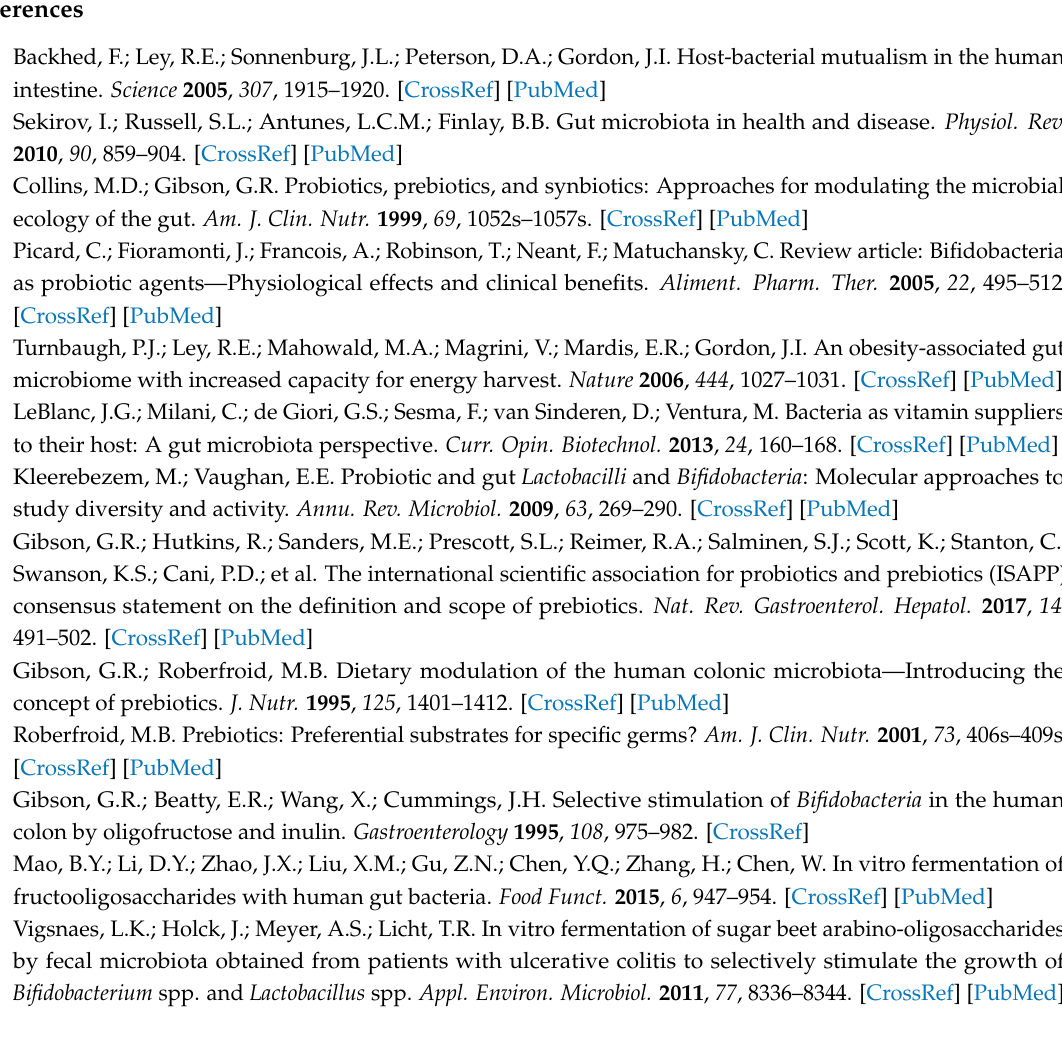
s1. Table S1: Dietary formula